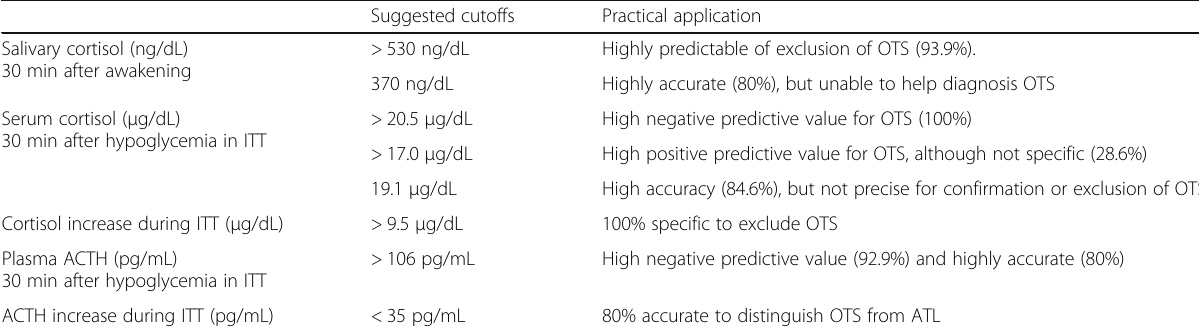
Table 6 Proposed cutoffs for overtraining syndrome Suggested cutoffs Practical